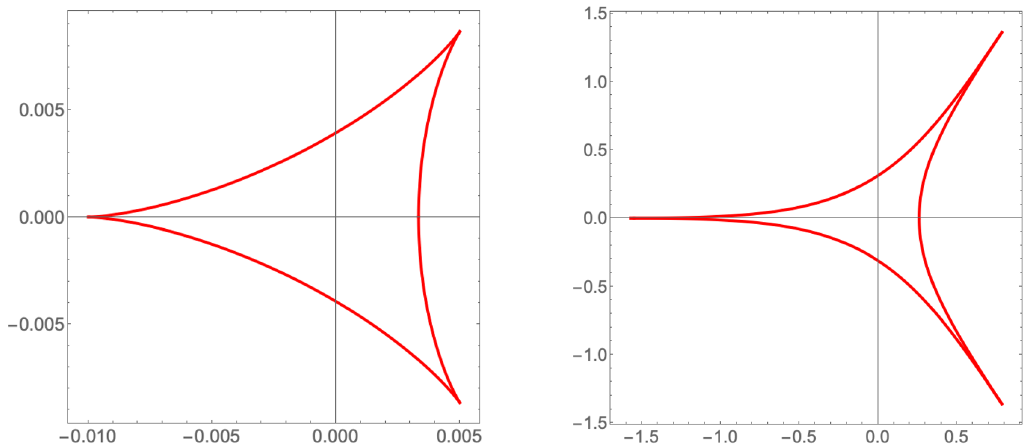
0 . 41 and ρ = π . The right panel shows the solution with 0 ’ 1 4 0 . 54 and ρ 1 . 03 . The latter type of solutions are 0 ’ 1 ’